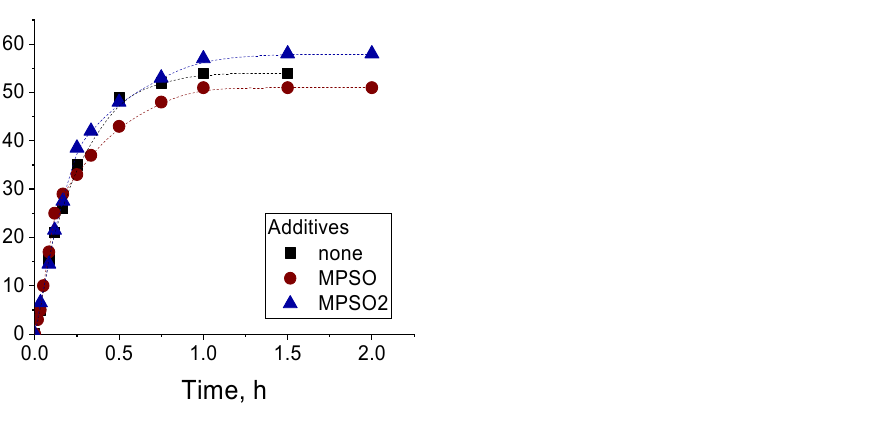
Figure 16. Hot catalyst filtration test for ( a ) CP and ( b ) MPS oxidation with H 2 O 2 in the presence of Zr-MMM-E (sample D ). Reaction conditions: MPS 0.1 mmol, catalyst 5 mg (0.0013 mmol Zr), Н 2 О 2 (30% aq.) 0.22 mmol, CH 3 CN 1 mL, 60 °C. The recycling behavior of the most active catalysts, sample D , was studied in several consecutive runs in the oxidation of CP and MPS with 30% H 2 O 2 (Figure 17a,b), respec- tively). The catalyst was regenerated by calcination at 550 °C between the runs. The cata- lyst revealed a rather stable recycling performance in the CP epoxidation (Figure 17a) and MPS oxidation (Figure 17b). Although some reduction of the turnover frequency (TOF) could be observed after the first use in MPS oxidation, the TOF remained constant and even increased during the subsequent runs.